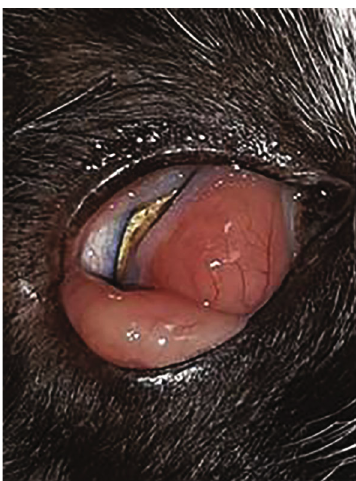
Figure 2: Edema of the conjunctiva and third eyelid of the right eye.